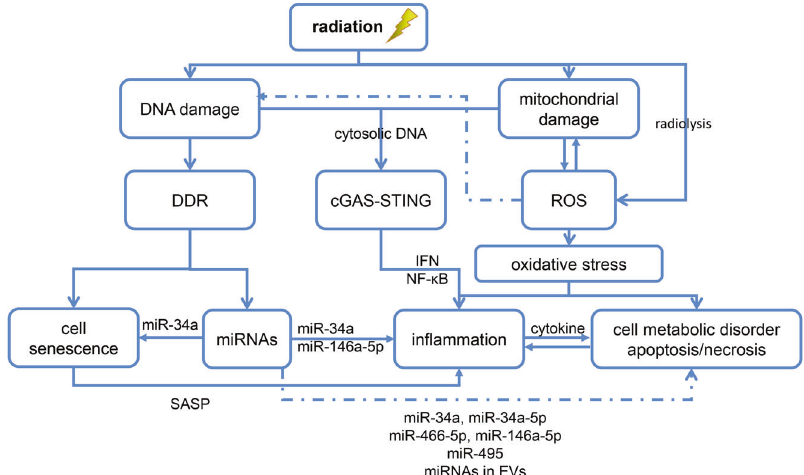
Fig. 1 Various biological processes are involved in RILI. After radiation exposure, excessive production of ROS in cells leads to oxidative stress and in fl ammation, resulting in cell damage. DNA damage in the nucleus and mitochondria can aggravate cell damage by activating cGAS-STING signal pathway. Cellular DNA damage response can participate in the occurrence and development of RILI by regulating the expression of speci fi c miRNA and inducing cell senescence. DDR: DNA damage response; ROS: Reactive oxygen species; SASP: senescence- associated secretory phenotype; EVs: extracellular